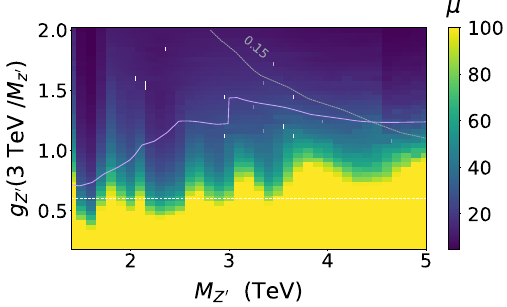
Fig. 12 μ for the 1 b -tag category of the ATLAS di-jet search [64] at each point in the scanned parameter space. The current search does not constrain the model. The solid purple line shows the current observed bound from all searches considered in this work. The dashed grey line shows the contour where (cid:10)/ M Z (cid:2) = 0 . 15 , and the region between the dashed white line and the bottom of the plot is favoured by the flavour and electroweak data at the 95% CL. Toward the extreme left-hand side oftheplot,ourpredictionsbecomemoreinaccurateduetounaccounted- / M 2 ) relative corrections for O ( M 2 Z Z (cid:2)